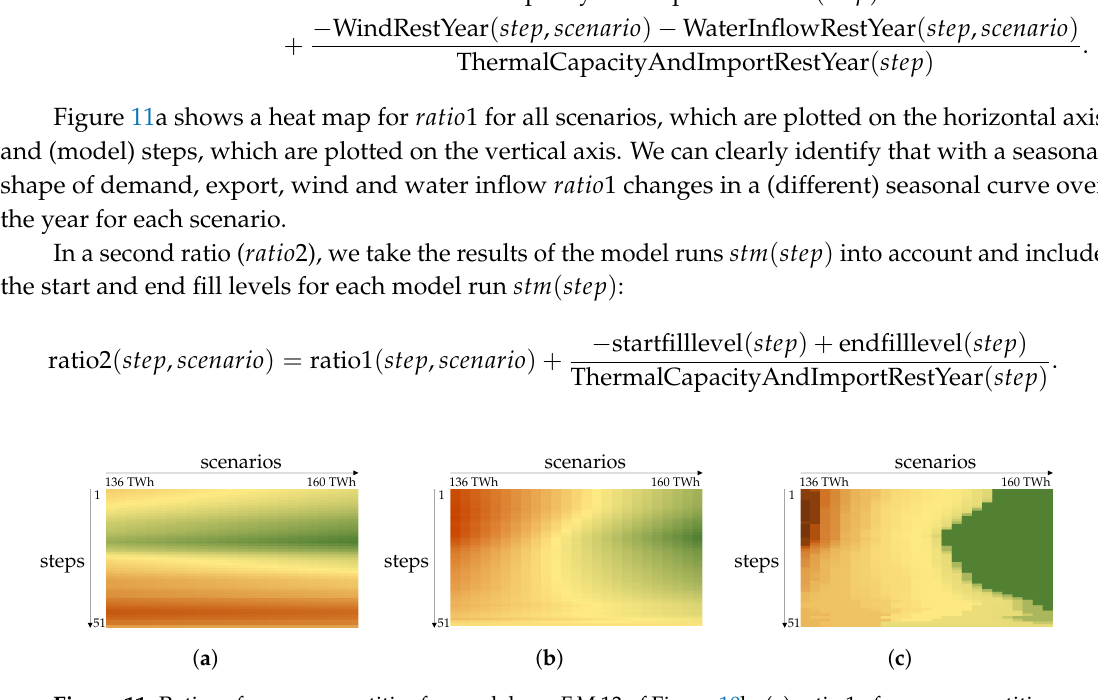
Figure 11. Ratios of energy quantities for model run EM 13 of Figure 10b. ( a ) ratio 1 of energy quantities for each stm ( step ) ; ( b ) ratio 2 of energy quantities for each stm ( step ) ; ( c ) prices of stochastic scenarios for each stm ( step )